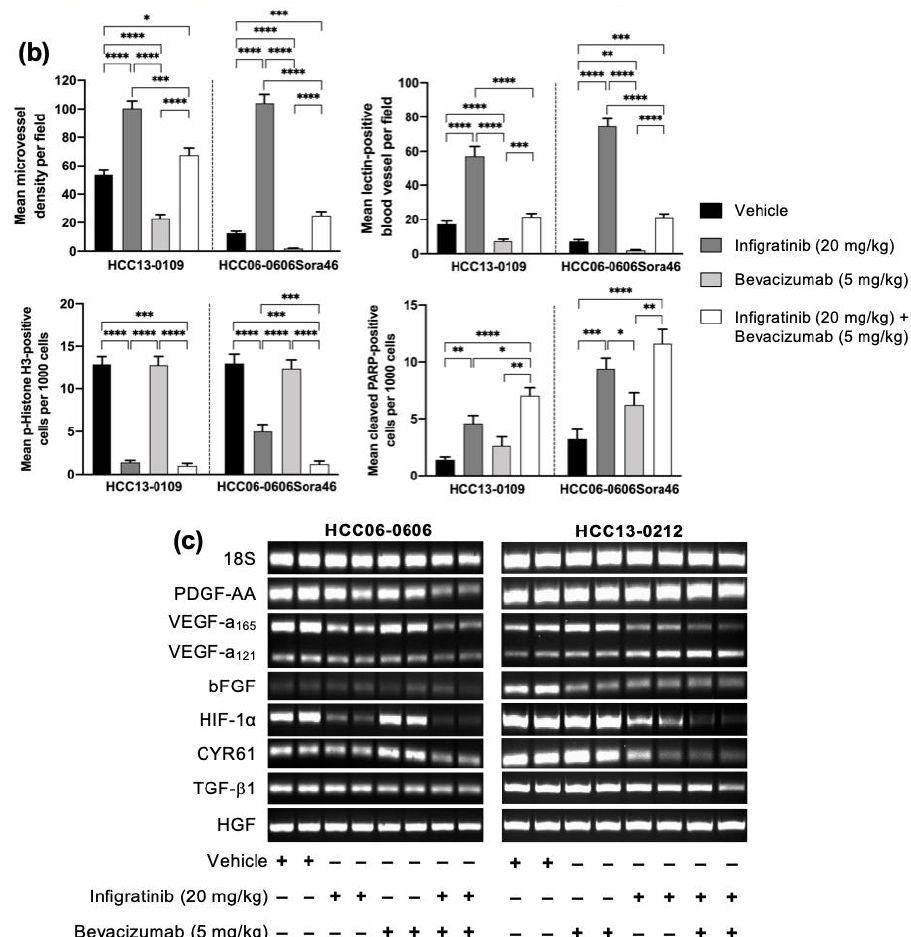
Figure 2. Effects of Infigratinib / Bevacizumab on angiogenesis, vessel normalization, tumor hypoxia, cellproliferation,apoptosis,andexpressionofangiogenicfactorsinHCCmodels. MicebearingHCC13-0109 xenografts were treated with vehicle, Infigratinib, Bevacizumab, or Infigratinib / Bevacizumab for 14 days, as described in Figure 1. Vehicle- and drug-treated mice were perfused with biotinylated lectin and injected with pimonidazole hydrochloride as described [23]. Tumors collected 2 h after the last treatments were processed for immunohistochemistry. Representative pictures of blood vessels stained with anti-CD31, proliferative cells stained with anti-p-histone H3 Ser10, cell death stained with anti-cleaved-PARP, functional blood vessels stained with lectin and tumor hypoxia stained with HypoxyProbe antibodies are shown ( a ). Bar: 50 µ m. The number of p-Histone H3 Ser10 and cleaved PARP-positive cells, among at least 500 cells counted per region was determined and plotted as the mean number of positive cells per 1000 cells ± SE. The mean lectin-positive blood vessels and microvessel density ± SE from five random fields at a magnification of × 100 was also quantified. The difference in staining-positive cells were compared using Student’s t -test ( b ). RNA extractions were performed according to the Qiagen RNeasy protocol. The levels of vascular endothelial growth factor (VEGF), PDGF-AA, bFGF, CYR61, TGF- β 1, HIF-1 α and HGF mRNA were determined using the ViiA7 Real-time PCR system. Representative ethidium bromide-stained gels are shown ( c ). The primers used for RT-PCR are listed in Table 2 (Materials and Methods). Experiments were repeated twice with similar results. * p < 0.05; ** p ≤ 0.01; *** p ≤ 0.001; **** p ≤